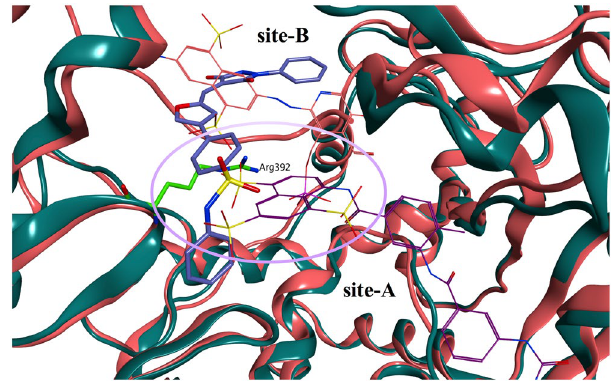
Figure 15. Overlap of site-A (suramin) and site-B (PPNDS) on the norovirus RdRp. Superposition of the MNV RdRp structure (dark green ribbon) in complex with suramin (carbon atoms in dark purple) and the human norovirus RdRp structure (salmon ribbon) in complex with PPNDS (carbon atoms in pink). 54 (carbon atoms in lilac) occupies the central core of site-B and extends up to the initial part of site-A (Arg392 area), where suramin places its sulphate